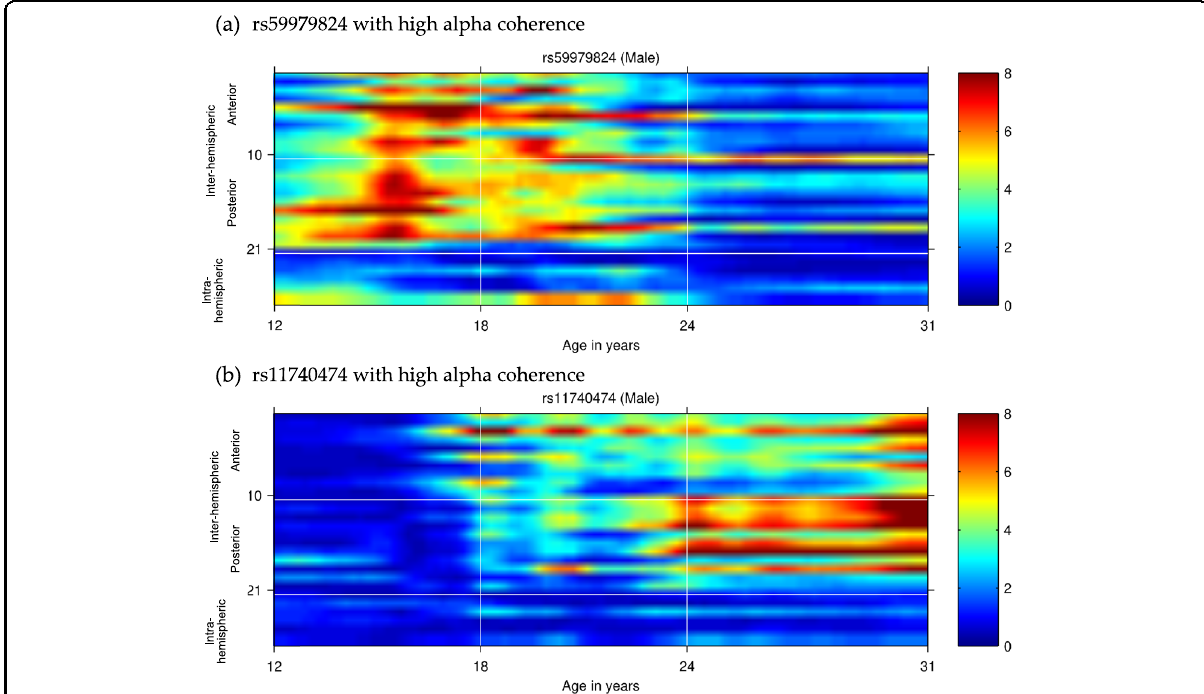
Fig. 3 Associations of rs59979824 (top panel a) and rs11740474 (bottom panel b) with high-alpha EEG coherence in males from ages 12 – 31. Age is represented on the x -axis and coherences are represented on the y -axis, with numbering 1 – 27 corresponding to coherences between bipolar electrode pairs illustrated in Fig. 1. Regional divisions are marked with horizontal white grid lines: 1 – 10 anterior (frontal-central); 11 – 21 posterior (central-parietal-occipital); 22 – 27 left and right intrahemispheric. Color values in the main panels indicate levels of signi fi cance ( p -values on a negative log 10 scale) as indicated by the color bars on the